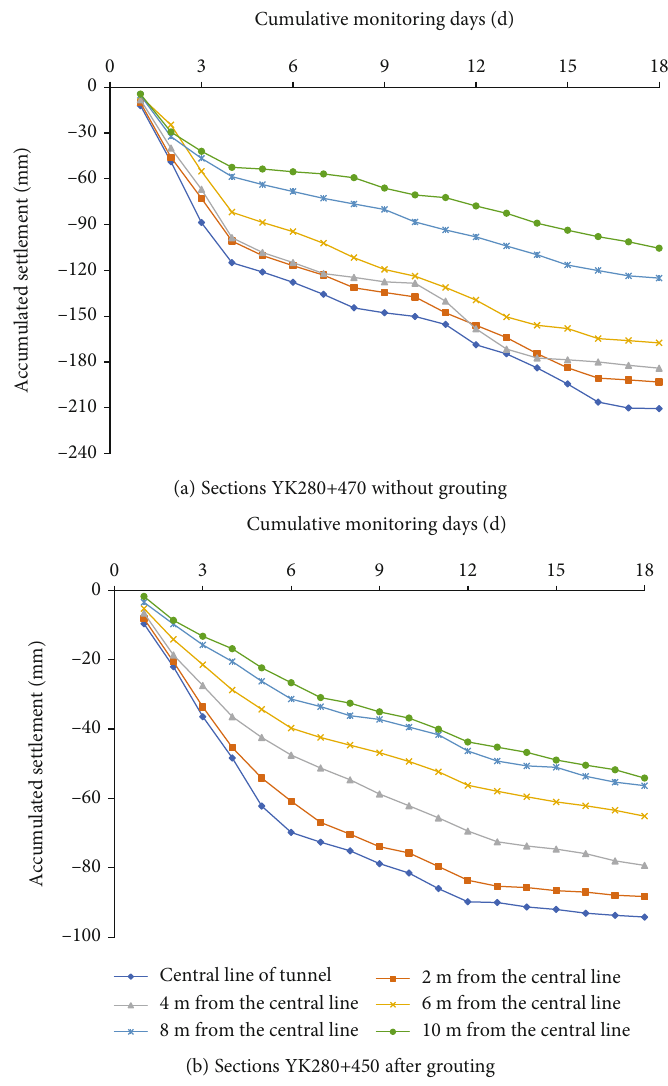
Figure 13: Surface settlement aging diagram of adjacent sections before and after